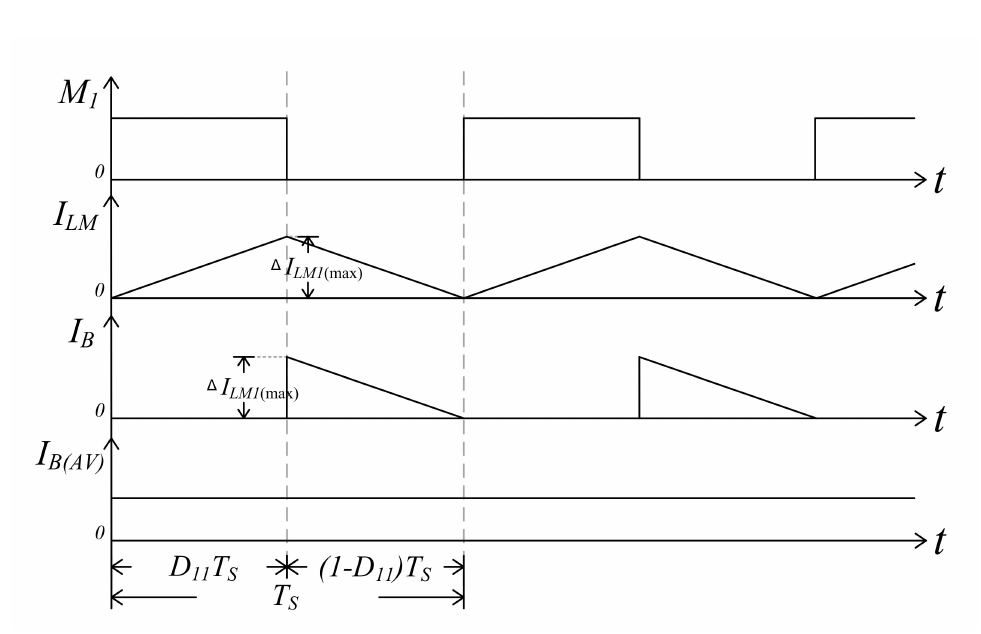
Figure 12. Conceptual waveforms of inductor current I Lm and charging current I B in the